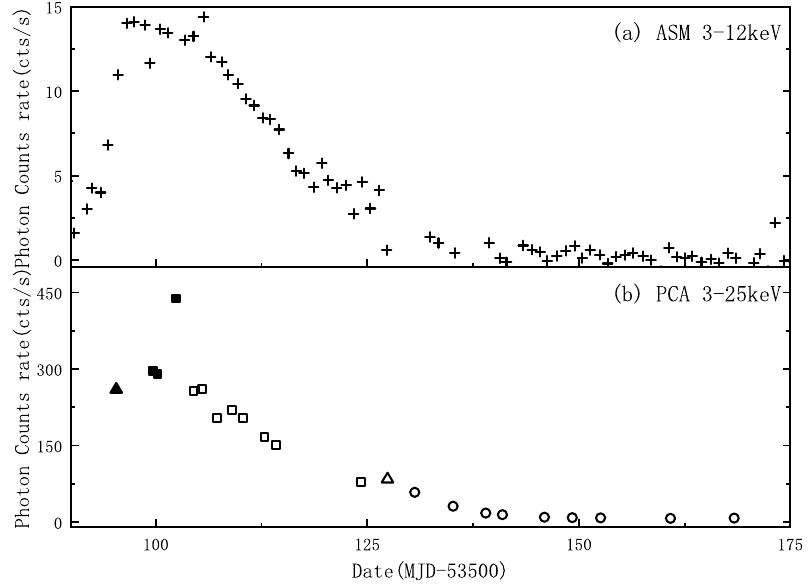
Figure 1. The light curve of H 1732-322 during the “faint“ 2005 outburst. ( a ) The observations from RXTE/ASM; ( b ) The observations from RXTE/PCA. The filled and open points represent the observations in the rising phase and the decay phase, respectively. The triangles, squares, and circles represent IMS, HSS and LHS,